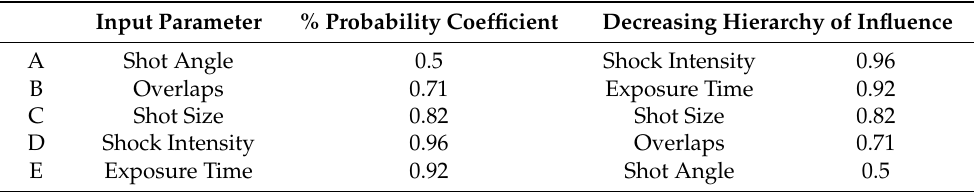
Table 6. Hierarchy of influence of LSP input parameters.